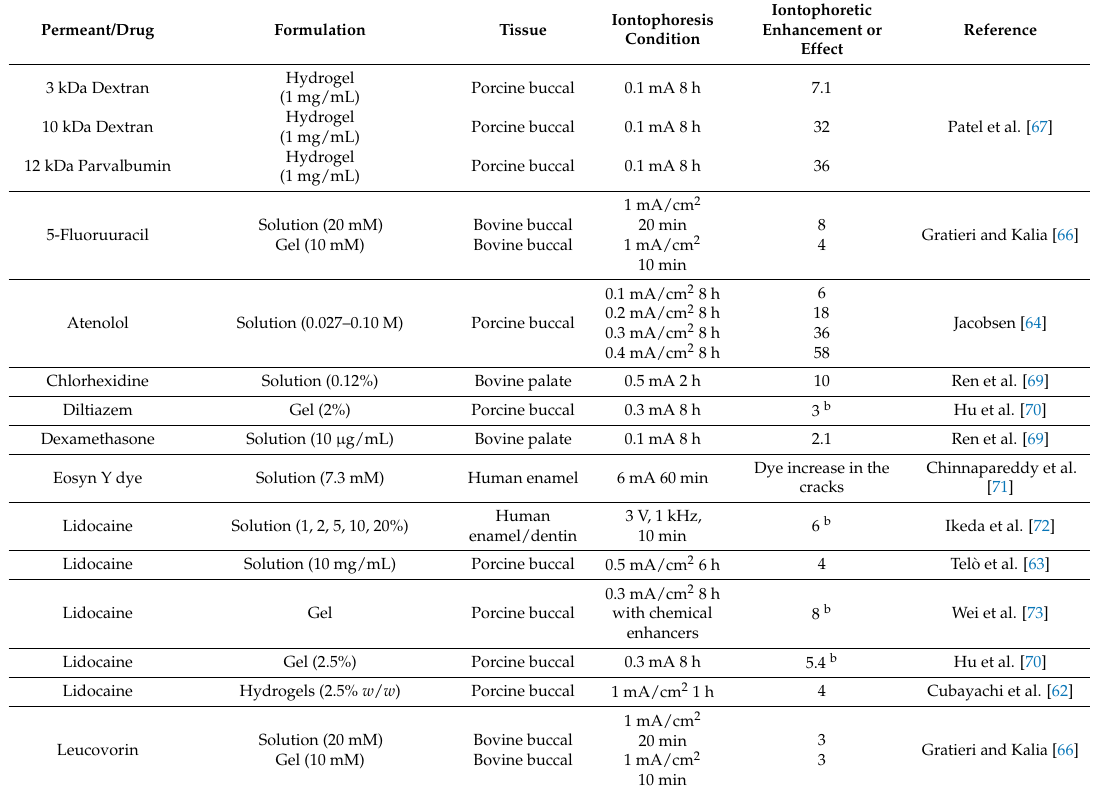
Table 1. Effect and enhancement in drug delivery due to iontophoresis.